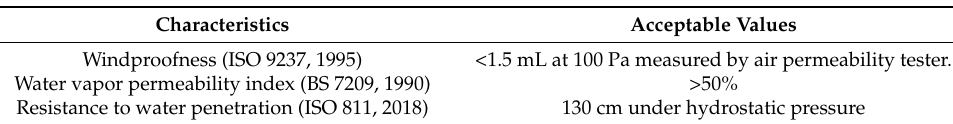
Table 1. Waterproof breathable fabric characteristics